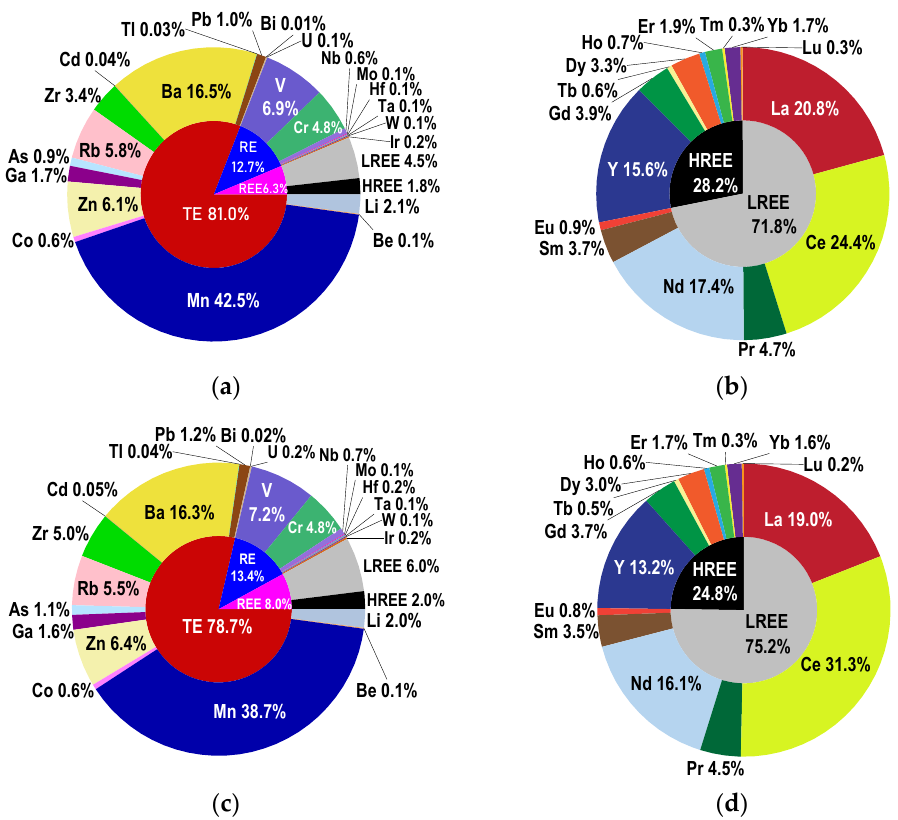
Figure 2. Relative contribution averages for July (( a ) — total quantified elements, ( b ) — rare earth elements) and October (( c ) — total quantified elements, ( d ) — rare earth elements) in sediment samples collected from Podu Iloaiei Dam Lake.